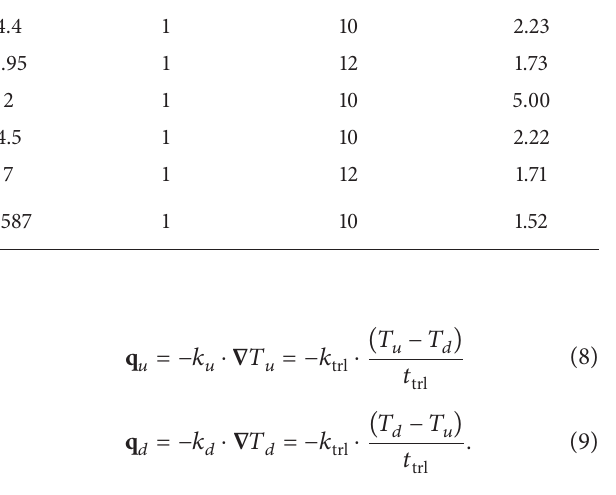
Table 2: Comparison of the safety factors used by HCPV industries and in the developed system. Cell dimensions Company [ mm × mm ]